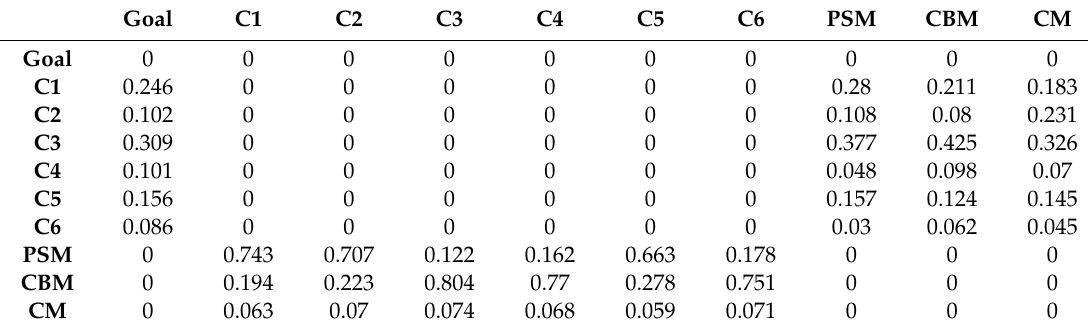
Table 5. The analytic network process (ANP) supermatrix for decision criteria and alternatives. Goal